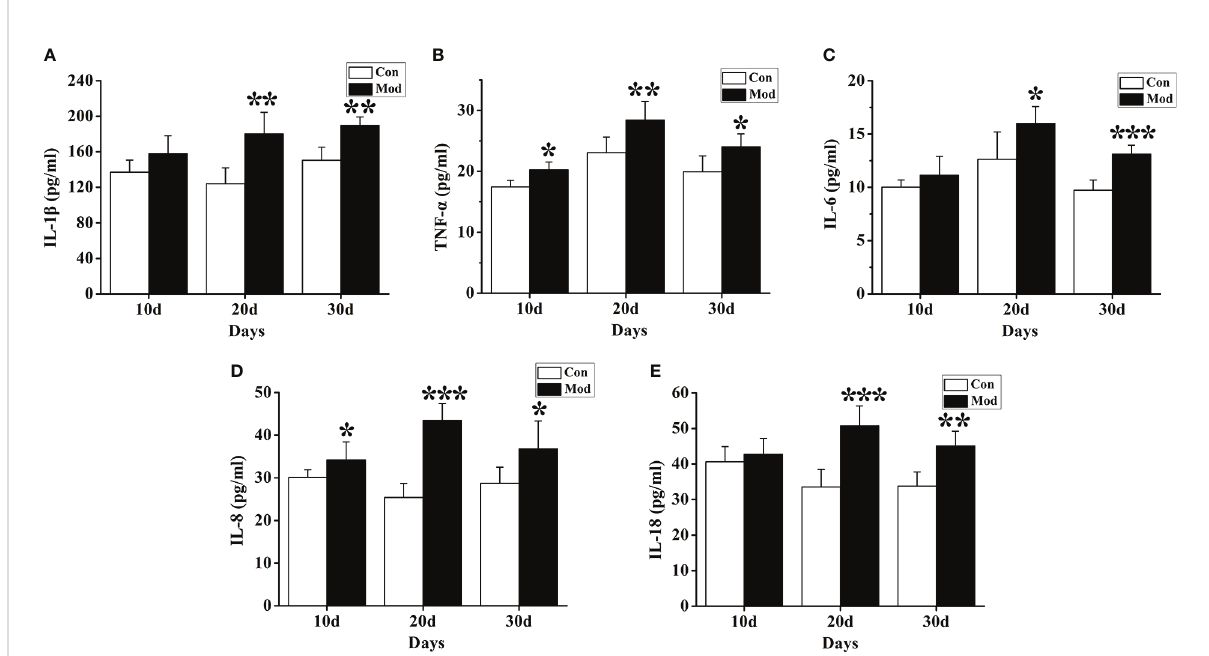
FIGURE 4 Expression of in fl ammatory factors in the serum of quails in different experimental stages. (A) The expression levels of IL-1 b in the serum. (B) The expression levels of TNF- a in the serum. (C) The expression levels of IL-6 in the serum. (D) The expression levels of IL-8 in the serum. (E) The expression levels of IL-18 in the serum. Data are expressed as mean ± SEM for 8 quails in each group. * P < 0.05, ** P < 0.01 and *** P < 0.001 versus Con